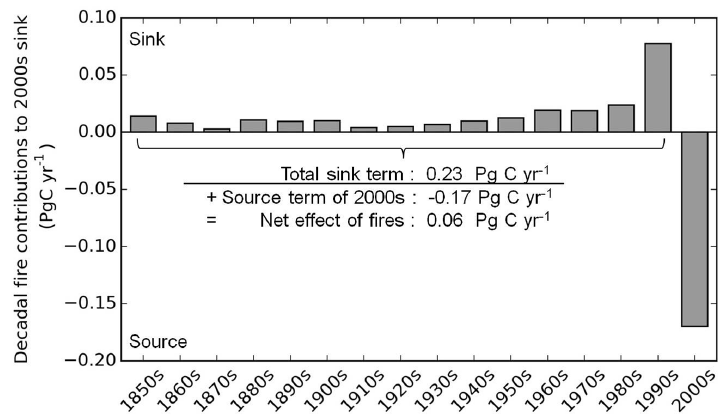
Figure 7. Contributions of decadal “fire cohorts” of 1850–2009 to the simulated carbon sink for 2000–2009. Fires within the 2000–2009 decade are a carbon source term and all fires before this decade are sink terms. For comparison, the carbon sink in the reference (fireON) simulation is 0.95Pg Cyr − 1 for 2000–2009.